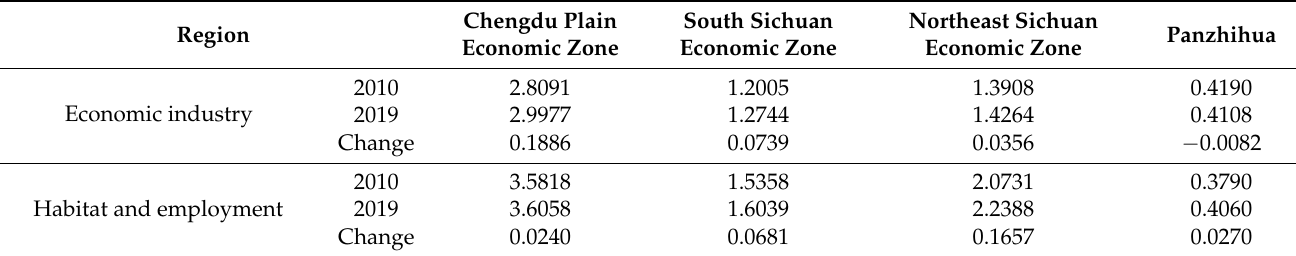
Table 6. The development level of each index